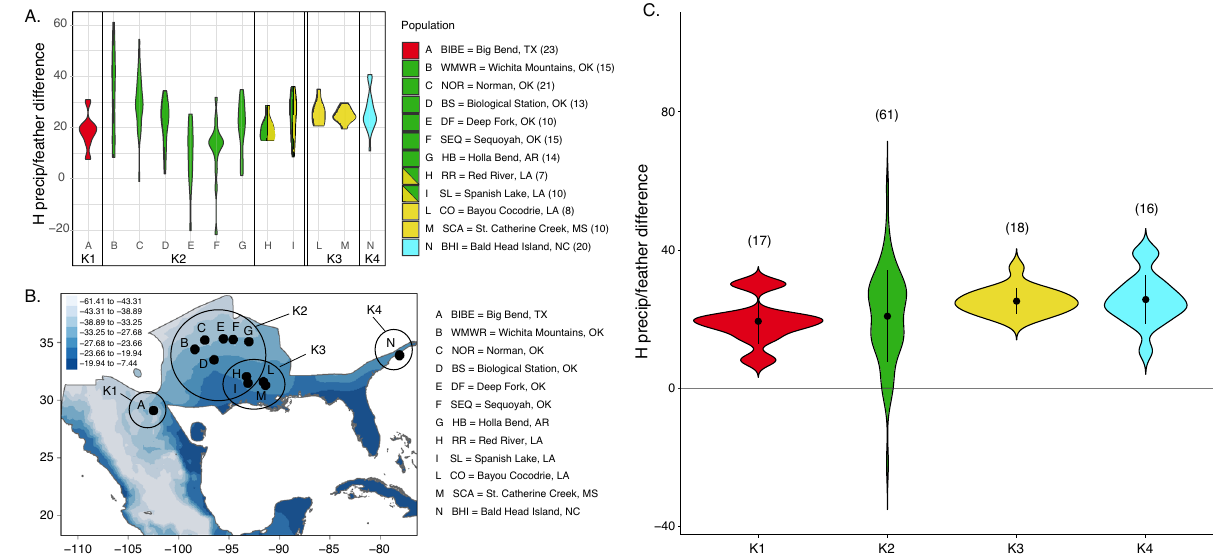
Figure 2. The variation of hydrogen stable isotope values across the breeding range of the Painted Bunting. Different colors match the clusters of the genetic analysis presented in Fig. 1. These genetic cluster (K1–4) correspond to an Eastern cluster (North Carolina; cyan), a Southwest cluster (Texas, red), a Central- Southeastern cluster (Louisiana, yellow), and a Central cluster, including populations from western Oklahoma to Arkansas (green). Sample sizes are presented in parentheses. ( A ) Violin plots resulting by subtracting stable isotope values of hydrogen in feathers (δ 2 H f ) from stable isotope values of hydrogen in precipitation (δ 2 H p ) at each sampling site. δ 2 H diff values close to zero indicate molting near the sampling location. The largest δ 2 H diff variation is found in the populations of the Central cluster (green). Samples from sites H and I could not be genetically assigned with certainty and are represented with two colors (green and yellow), to indicate that could be grouped to either cluster K2 or cluster K3. ( B ) Map of hydrogen stable isotope values in precipitation (δ 2 H p ) across the Painted Bunting range and sampling locations. ( C ) Violin plots of δ 2 H diff values of birds grouped in four distinct clusters based on genetic membership (K1–4) and for which individual δ 2 H f values were also available. As shown in panel A, the largest δ 2 H diff variation occurs in the Central cluster populations (green). A detailed list of samples used to generate the plots in panel ( A,C ) is included in the supplementary material (Tables S2, S3).